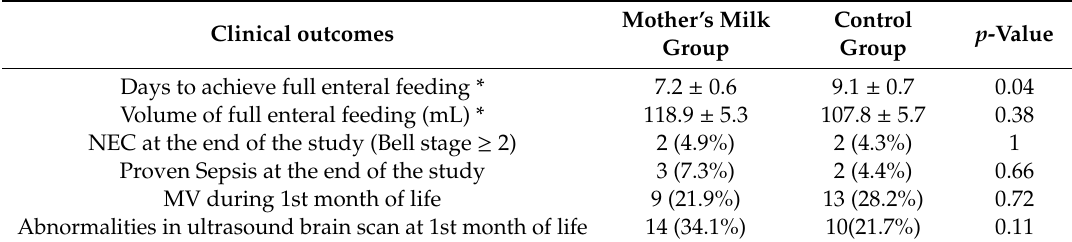
Table 2. Clinical outcomes at the time of